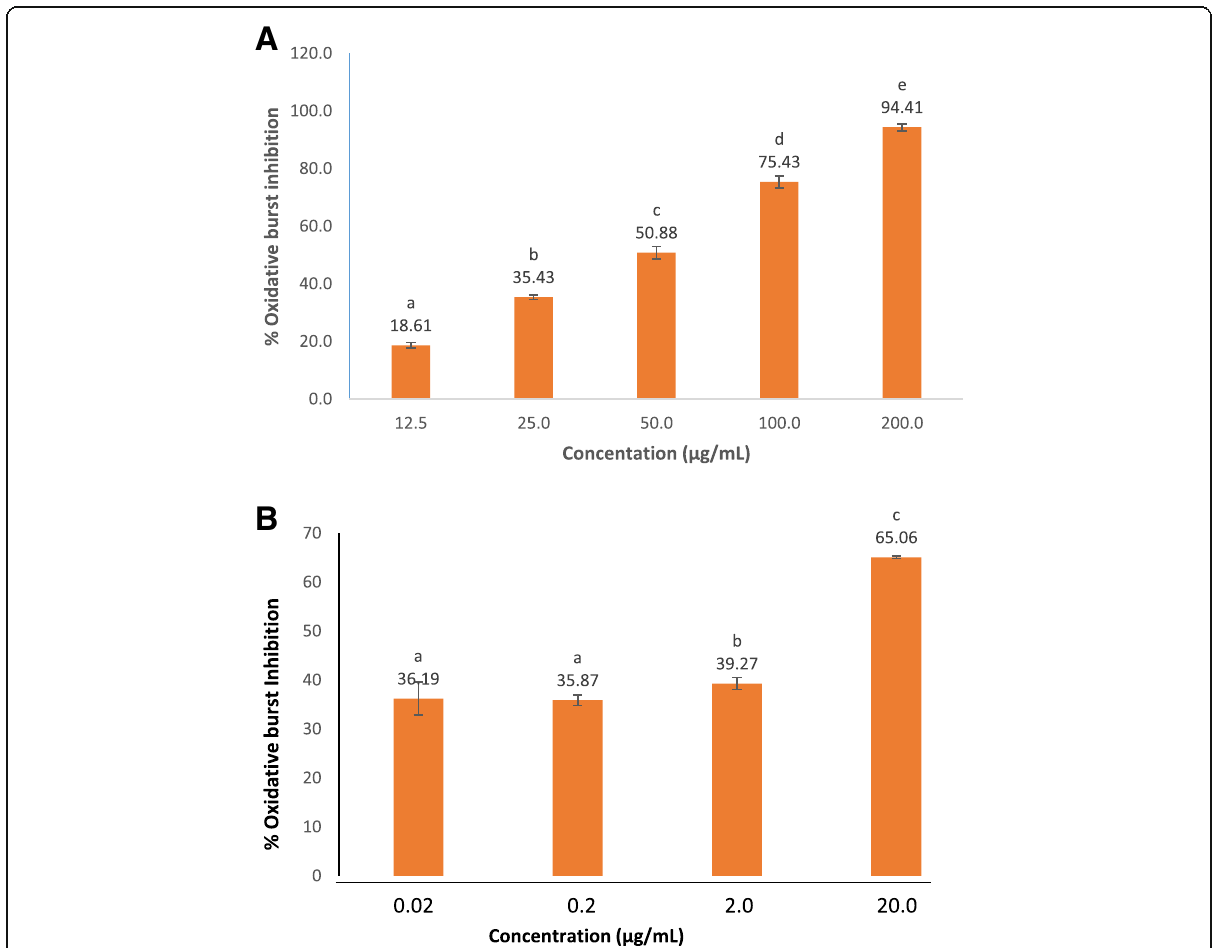
Fig. 3 Oxidative burst inhibitory activities of ethanol extract of bark of Flacourtia indica on human whole blood ( a ) and polymorphoneutrophils ( b ). Results are presented as mean ± SE(N = 3). Means followed by the same letter are not significantly different at p <